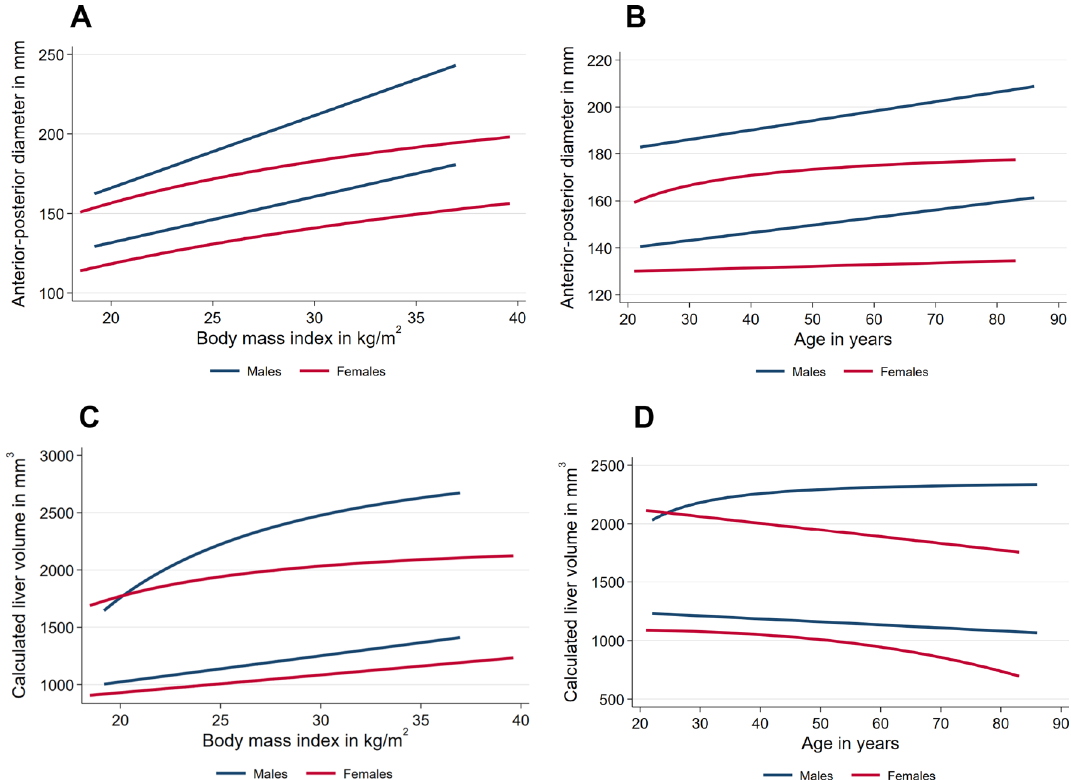
Figure 3. Correlation of AP diameter and the calculated liver volume with increasing BMI ( A , C ) and age ( B , D ). Percentiles of AP diameter (percentiles 5, 25, 50, 75, 95) by BMI and Age for men (blue) and women